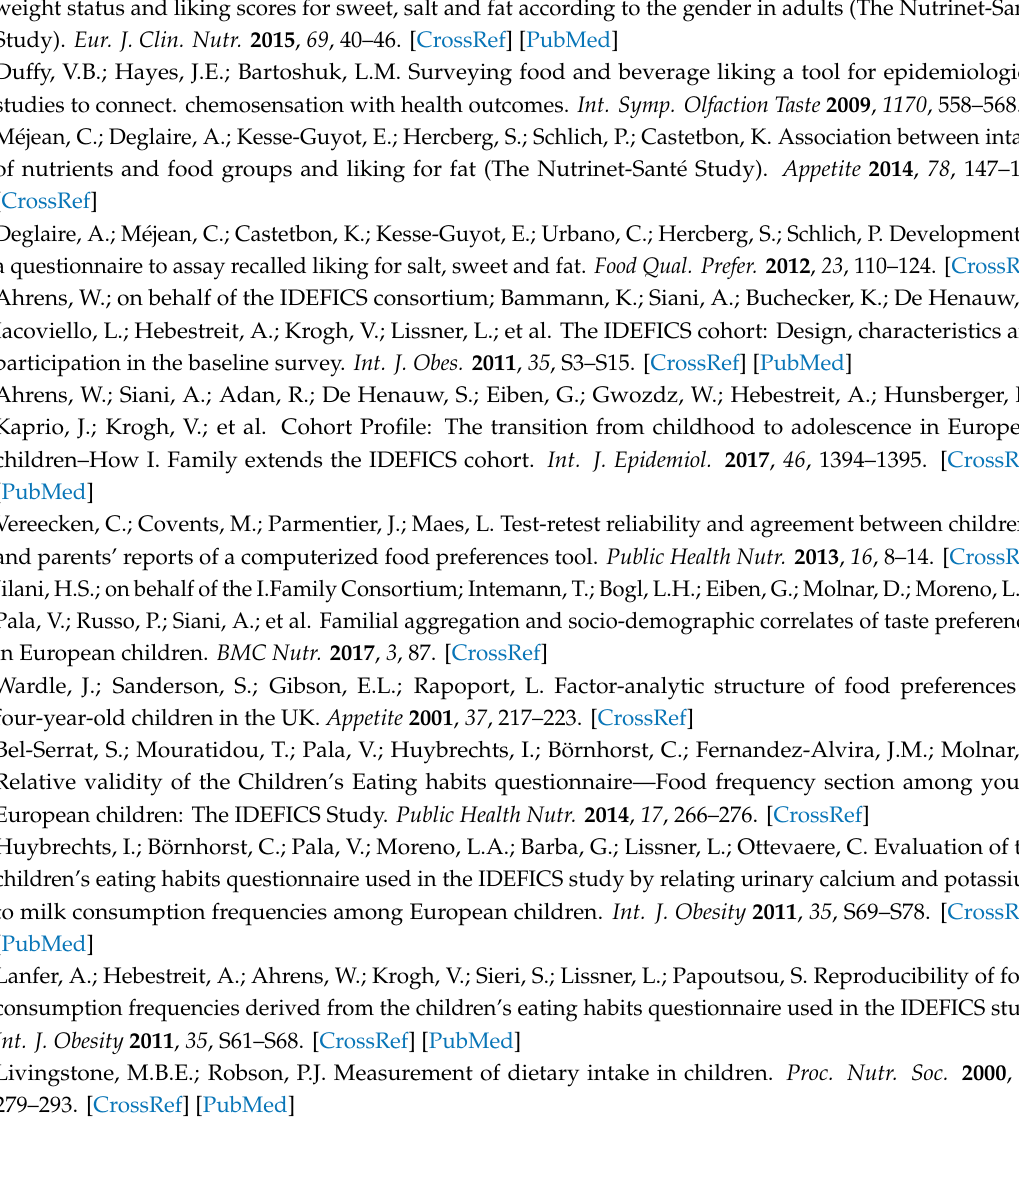
Table S1: Estimates of fixed e ff ect sizes with reference category in parentheses in relation to sweet and fatty food consumption frequencies in adults, adolescents and